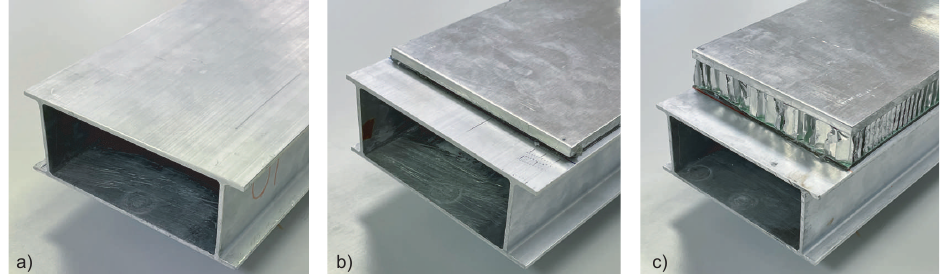
Figure 2. Types of beams: ( a ) without CLD; ( b ) CLD patch with uniform constraining layer; ( c ) CLD patch with honeycomb constraining